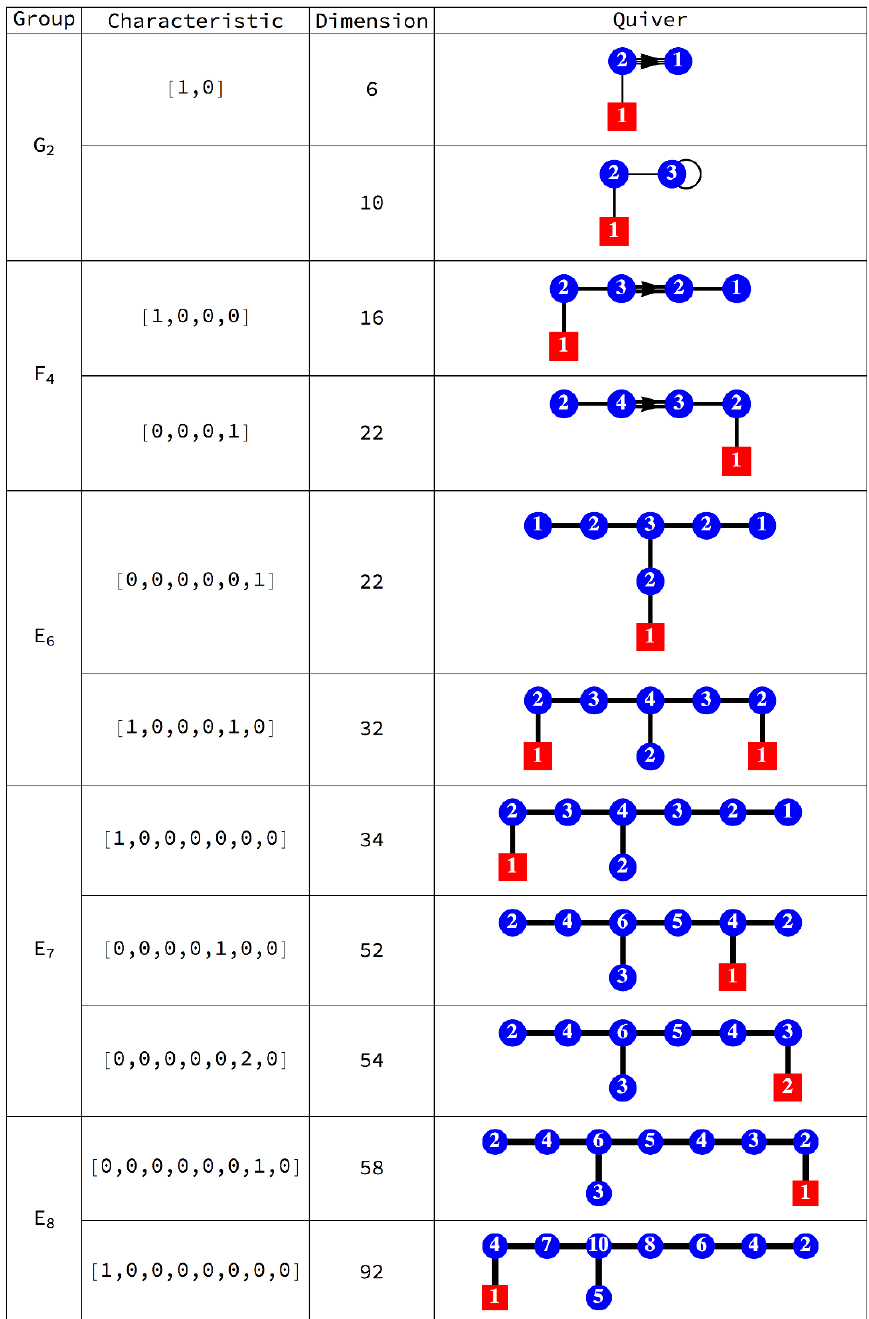
Figure 1 . Exceptional group quivers with characteristic height 2. Round (blue) nodes denote unitary gauge nodes of the indicated rank. Square (red) nodes denote numbers of (cid:13)avour nodes. The Characteristics coincide with the numbers of (cid:13)avour nodes attached to each gauge node. The dimension of a Coulomb branch nilpotent orbit construction equals twice the sums of the ranks of its gauge nodes. Note that the quiver for the G 2 10 dimensional nilpotent orbit is not based on its Characteristic (see discussion).